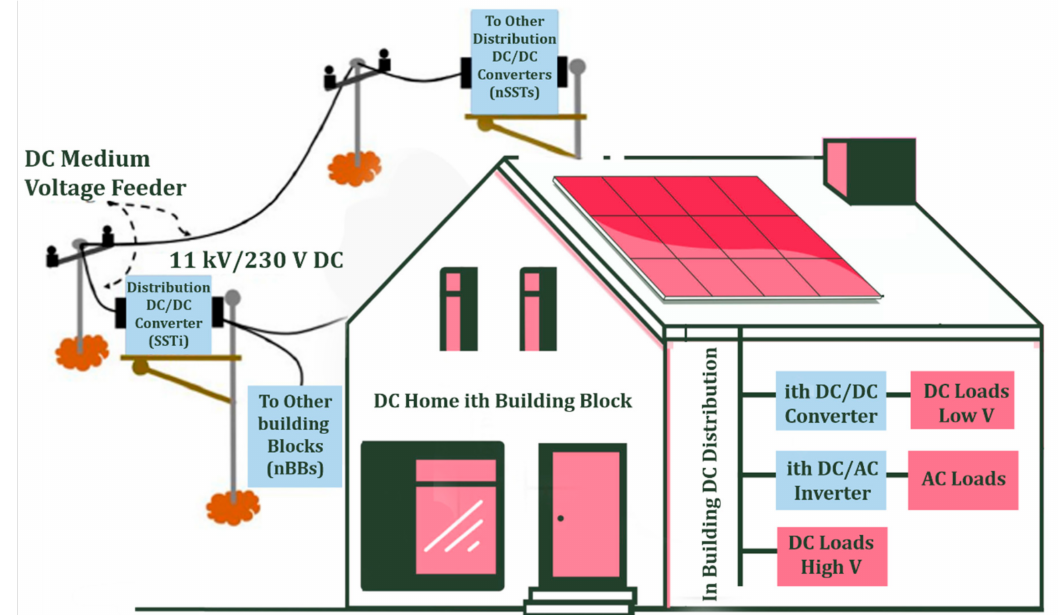
Figure 7. Overall system model for mathematical